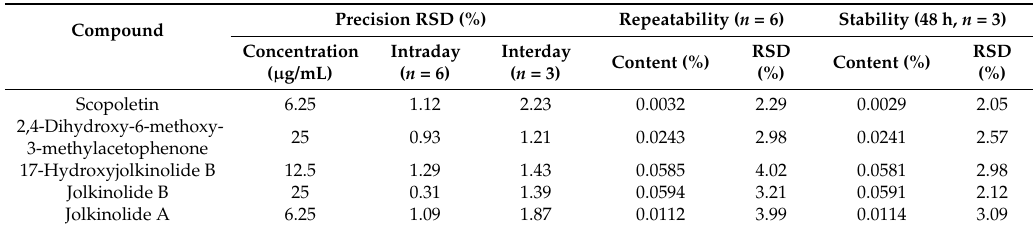
Table 4. Precision, repeatability, and stability of Scopoletin, 2,4-Dihydroxy-6-methoxy-3-methylacetophenone, 17-Hydroxyjolkinolide B, Jolkinolide B, and Jolkinolide A in Euphorbia fischeriana expressed with RSD (%).